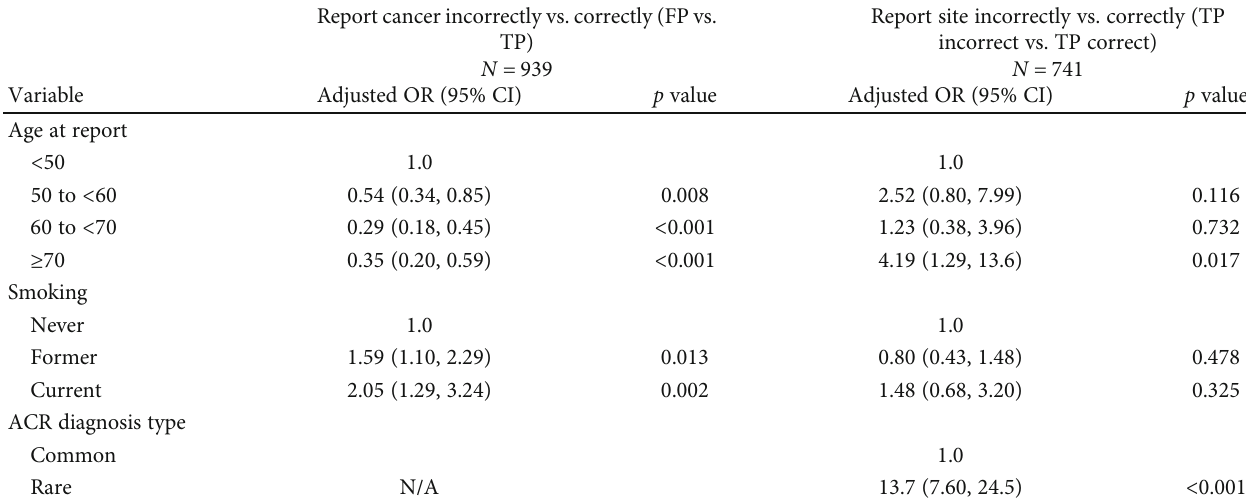
Table 4: Factors associated with false positive and incorrect site